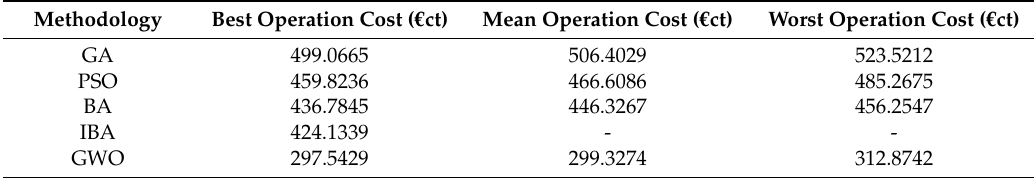
Table 6. Demonstration of operation dispatches cost of the microgrid (MG) of Scenario C.